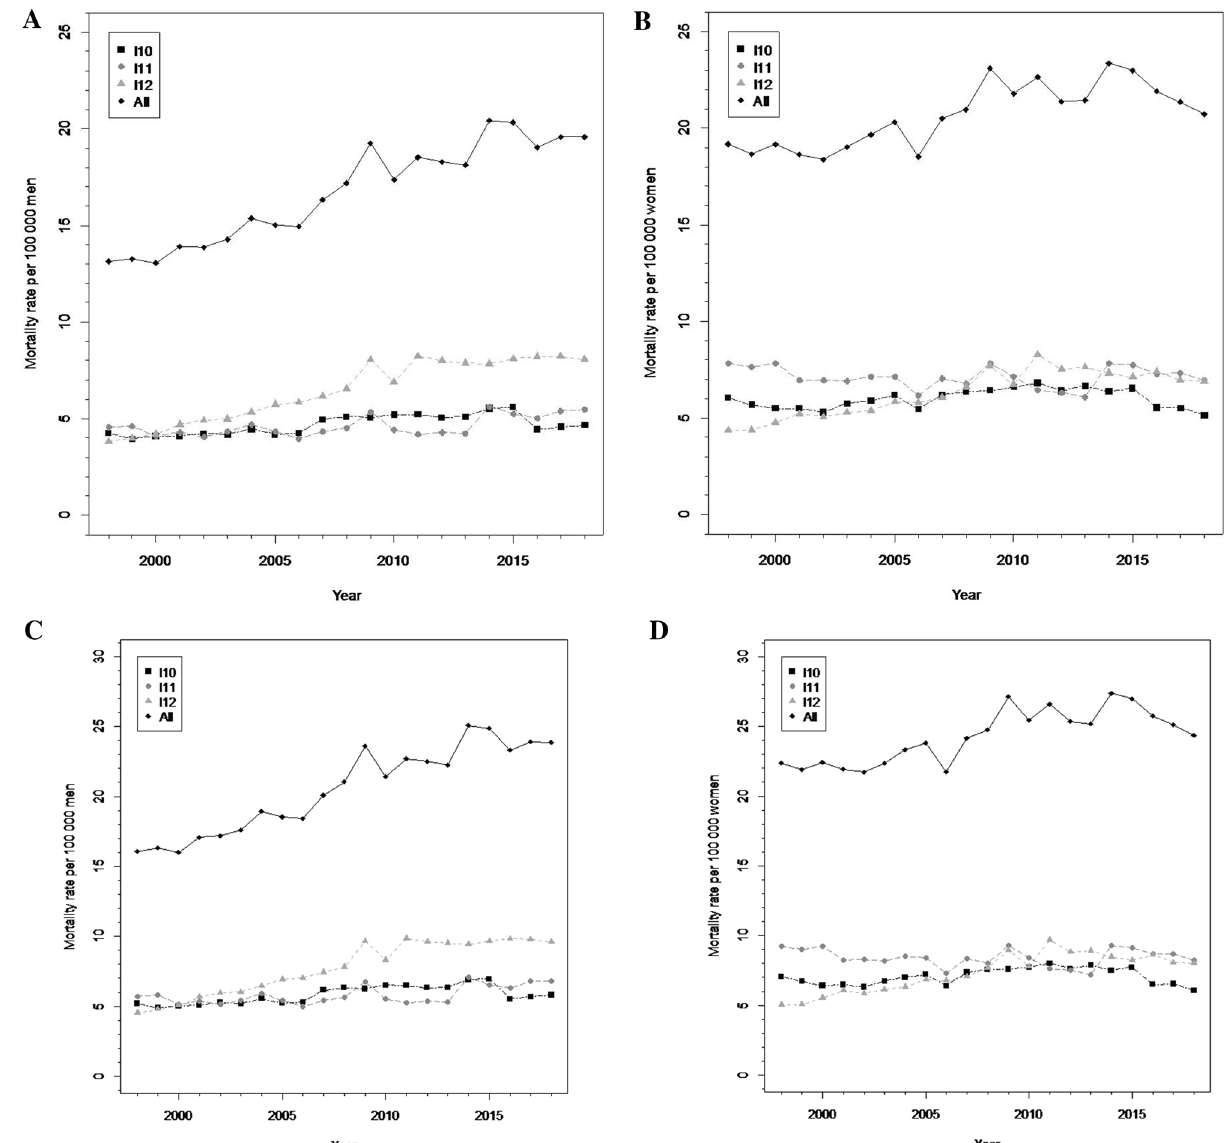
Figure 1. Mortality trends of hypertension and specific causes (per 100 000 population) by sex. Mexico, 1998–2018. ( A ) Men a . ( B ) Women a . ( C ) Men b . ( D ) Women b . I10, essential hypertension; I11, hypertensive heart disease; I12, hypertensive kidney disease; All, all underlying causes due to hypertension (I10, I11, I12, I13 and I15); a Adjusted mortality rate by age from 2010 Mexican Census. b Adjusted mortality rate by age from World Population (WHO